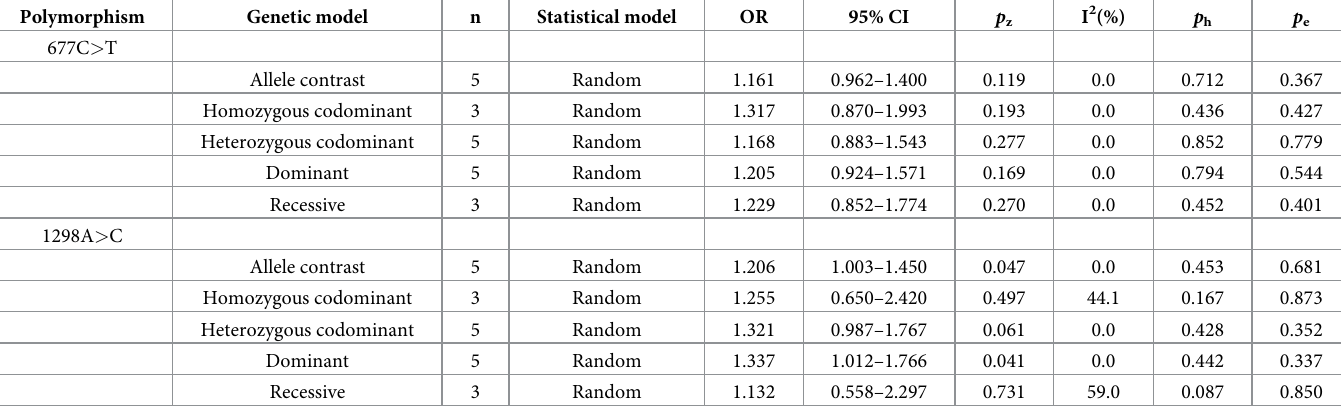
Table 5. Summarized ORs with 95% CIs for the association between MTHFR polymorphisms and ADHD.